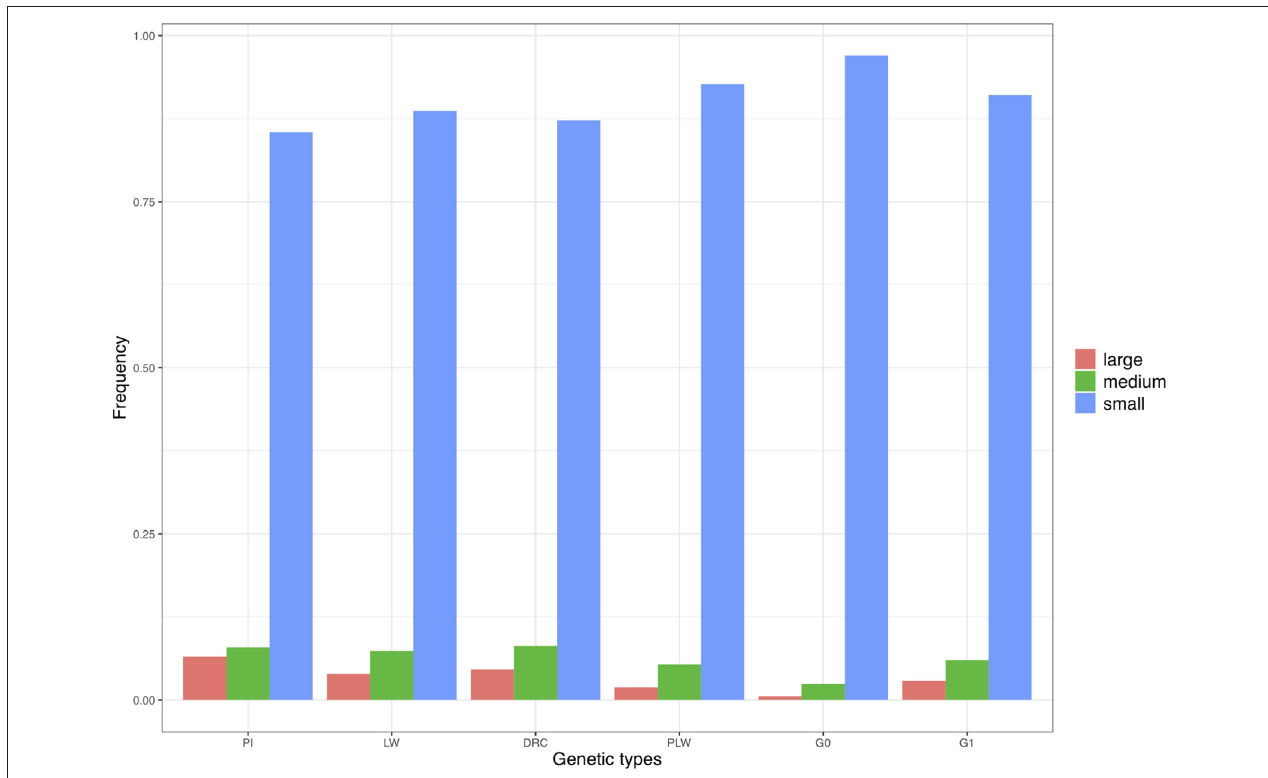
FIGURE 9 | Frequency of runs of homozygosity (ROH) in the three size classes per genetic type. DRC, Duroc; G0, (Pietrain × Large White) × Duroc offspring; G1, G0 × G0 offspring; LW, Large White; PI, Pietrain; PLW, Pietrain × Large White.